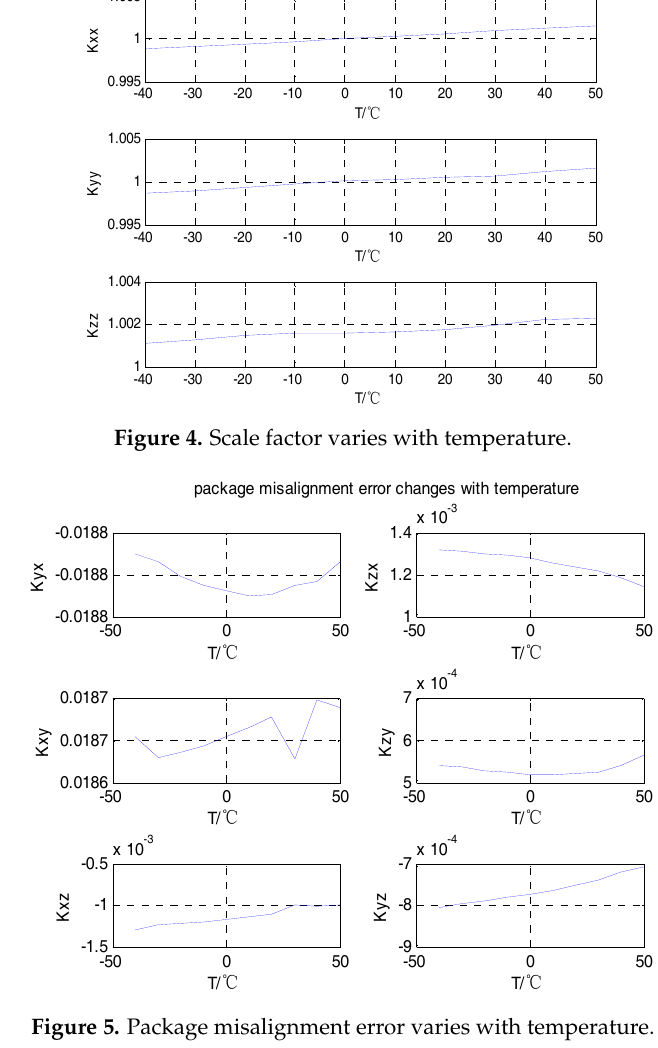
Sensors 2018 , 18 , x FOR PEER REVIEW Figure 5. Package misalignment error varies with temperature. Figure 5. Package misalignment error varies with temperature. Figure 5. Package misalignment error varies with temperature.